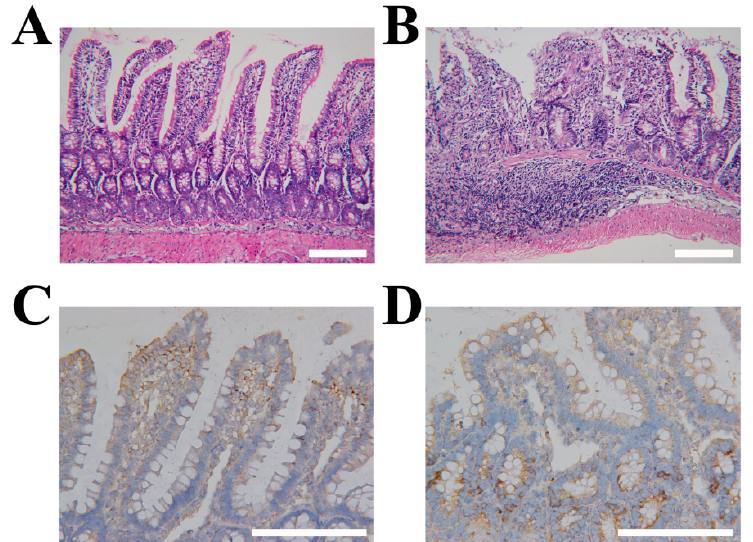
Figure 4. Staining rats’ intestines slices with HE or LYVE-1 antibody (the second antibody was HRP labeled). ( A ) Normal rats’ intestines slice stained with HE. ( B ) DSS- and alcohol-treated rats’ intestines slice stained with HE. ( C ) Normal rats’ intestines slice stained with LYVE-1 antibody. ( D ) DSS- and alcohol-treated rats’ intestines slice stained with LYVE-1 antibody. The scale bars equal 200 µ